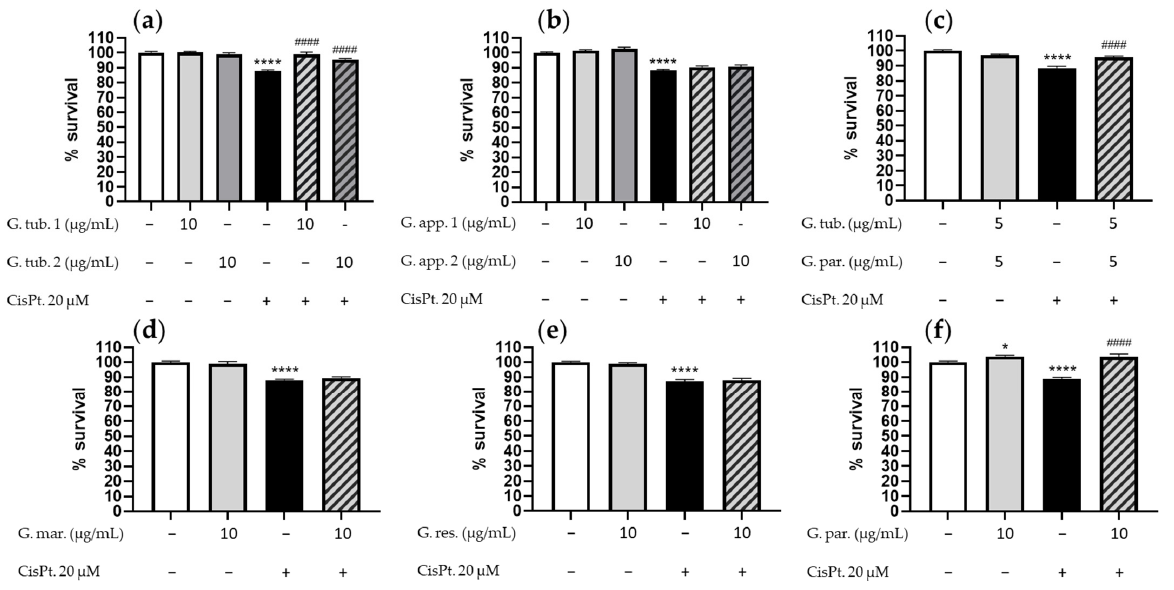
Figure 1. Cell survival rate determined using the CCK-8 assay after a 24 h treatment with CisPt 20 µM and/or: ( a ) one of the G. tub. extract (10 µg/mL); ( b ) one of the G. app. extract (10 µg/mL); ( c ) the G. tub. and G. par. extract (each at 5 µg/mL); ( d ) the G. par. extract (10 µg/mL); ( e ) the G. mar. extract (10 µg/mL); ( f ) the G. res. extract (10 µg/mL). Results are shown as mean ± SD of six inde- pendent experiments (**** p < 0.0001 and * p < 0.05 compared to controls; #### p < 0.0001 compared to CisPt. 20µM). The signs + and − indicate the presence or the absence of the corresponding treatment, respectively.